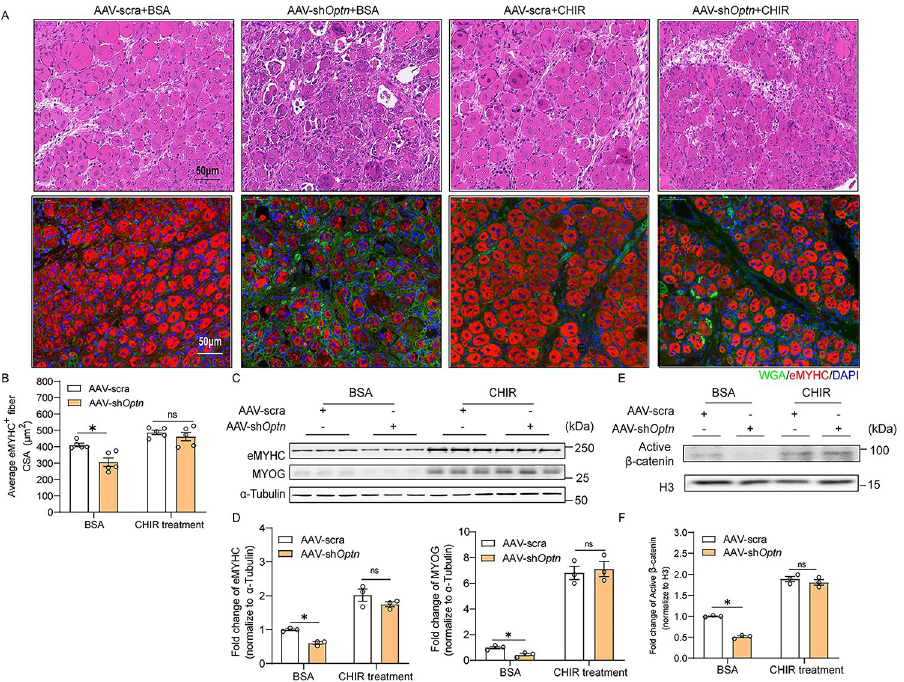
Fig 7. Inhibition of GSK3 β rescues impaired skeletal muscle regeneration induced by Optn KD. (A) Representative HE staining and immunofluorescence analysis of eMYHC + fibers in scramble shRNA or sh Optn TA muscle (intramuscular injection of CHIR or BSA at 2.5 days postinjury) at 5 days postinjury ( n = 5 mice in each group). Scale bar = 50 μ m. (B) Average CSA of regenerating eMYHC + myofibers at 5 days postinjury ( n = 5 mice in each group). (C, D) Representative immunoblotting analysis (C) and quantification (D) of myogenic markers (eMYHC and MYOG) in scramble shRNA or sh Optn TA muscle (intramuscular injection of CHIR or BSA at 2.5 days postinjury) at 5 days postinjury ( n = 3 mice in each group). (E, F) Representative immunoblotting analysis (E) and quantification (F) of active β -catenin protein levels in nuclear lysates extracted from scramble shRNA or sh Optn TA muscle (intramuscular injection of CHIR or BSA at 2.5 days postinjury) at 5 days postinjury ( n = 3 mice in each group). Data are presented as mean ± SEM. � P < 0.05 versus control. The underlying data for this figure can be found in S1 Data . The original blot for this figure can be found in S1 Raw Image . AAV, adeno-associated viral vector; BSA, bovine serum albumin; CSA, cross-sectional fiber area; eMYHC, embryonic myosin heavy chain; GSK3 β , glycogen synthase kinase 3 β ; HE, hematoxylin–eosin; H3, histone H3; Optn, optineurin; SEM, standard error of the mean; shRNA, short hairpin RNA; WGA, wheat germ agglutinin; TA, tibialis